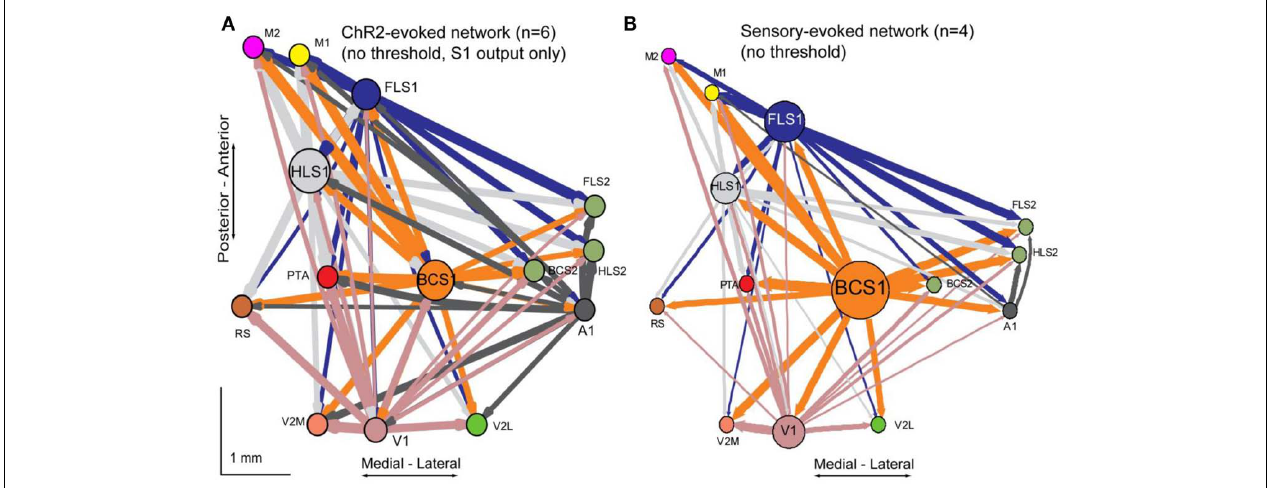
the primary sensory areas (FLS1, HLS1, BCS1,V1, and Al) was used here.The elements (weights) were not thresholded. (B) A weighted, directed network diagram was derived following sensory stimulation of the forelimb, hindlimb, whisker, visual system, and auditory system in the unilateral preparation. Node size is proportional to the strength of connections per node (sum of weights). Arrow thickness is proportional to the weight of an individual